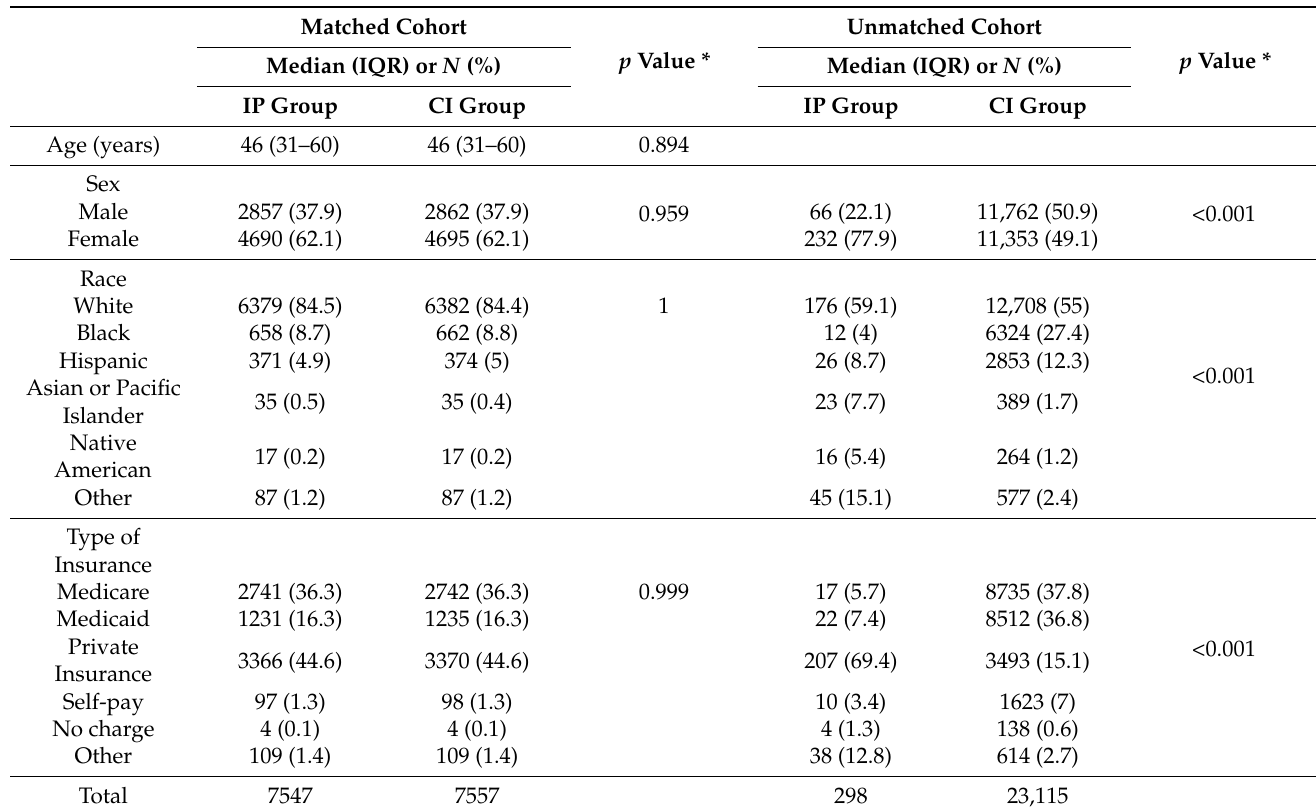
Table 2. Comparison of Baseline Characteristics of Insulin Pump Group and Conventional Insulin Group After Matching. Matched